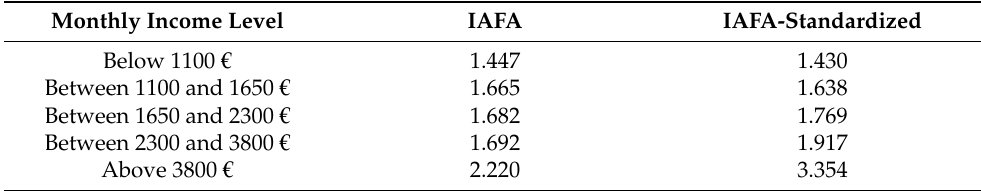
Table A5. IAFA and standardized IAFA sampling errors by monthly income